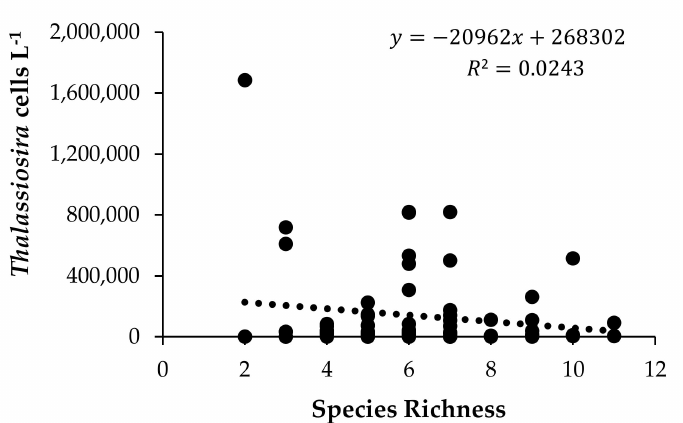
Figure 6. Species richness of Thalassiosira identified using HTS compared to cell counts obtained using LM for 80 field samples between